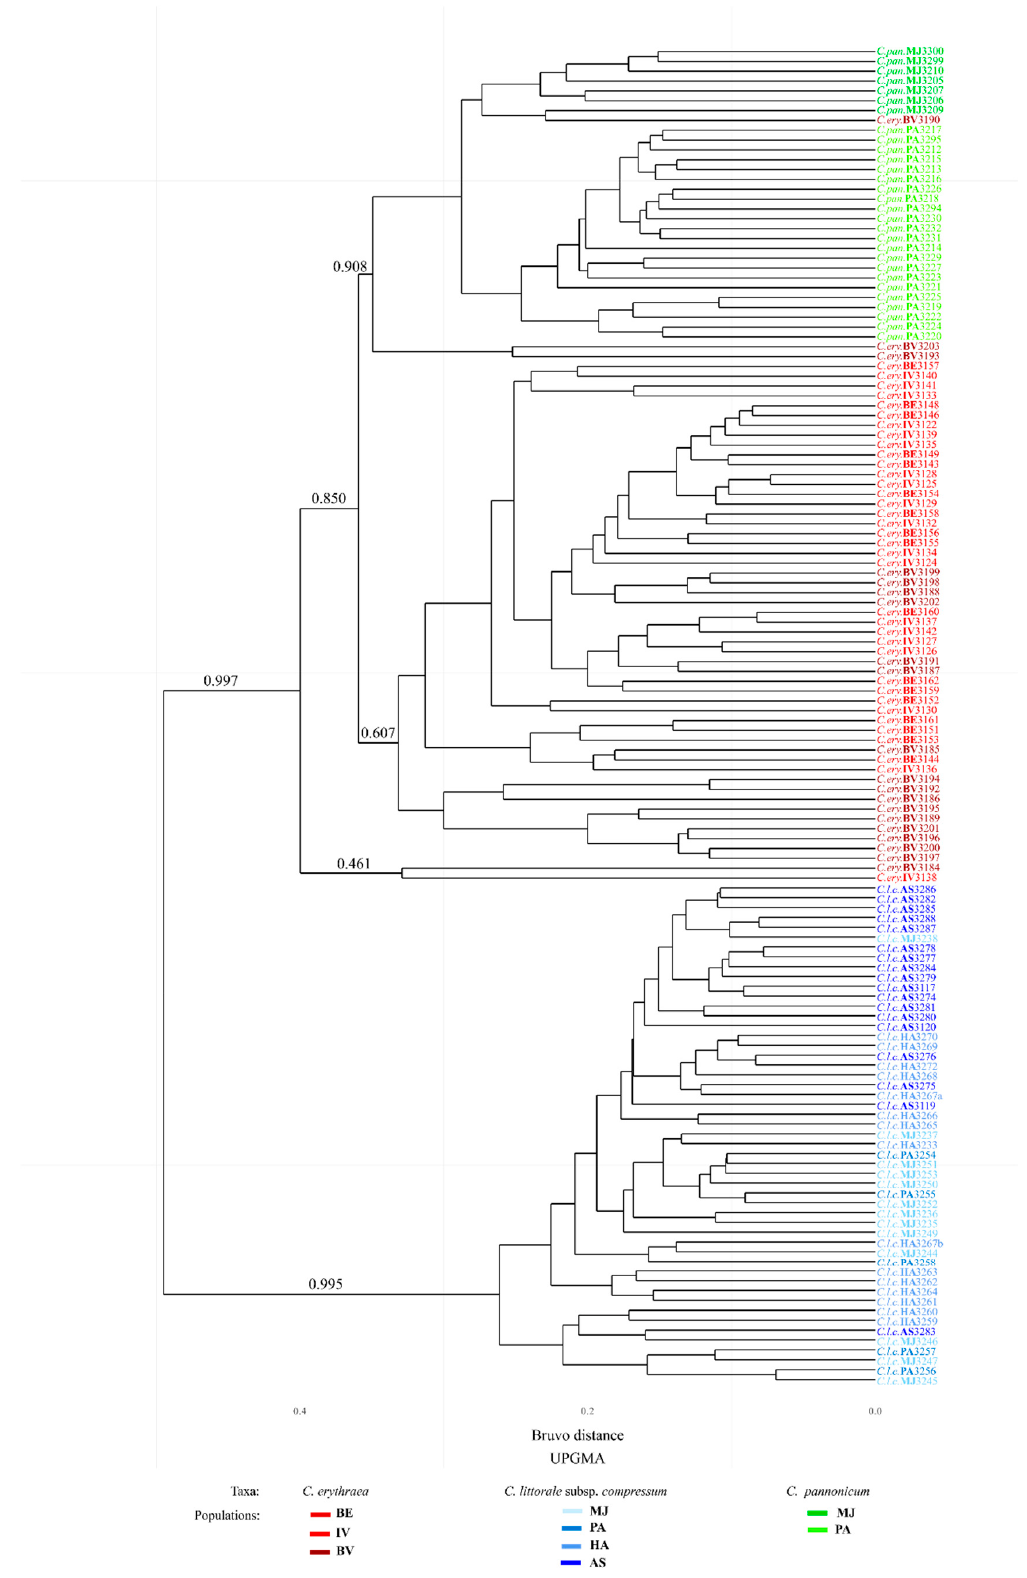
Figure 3. Graphical presentation of the hierarchical cluster analysis (HCA) by UPGMA method based on Bruvo genetic distances, which were obtained from the allele frequencies at eight EST-SSR loci. Bootstrap values are indicated on main clusters and sub-clusters. For population codes, please refer to Table 3.